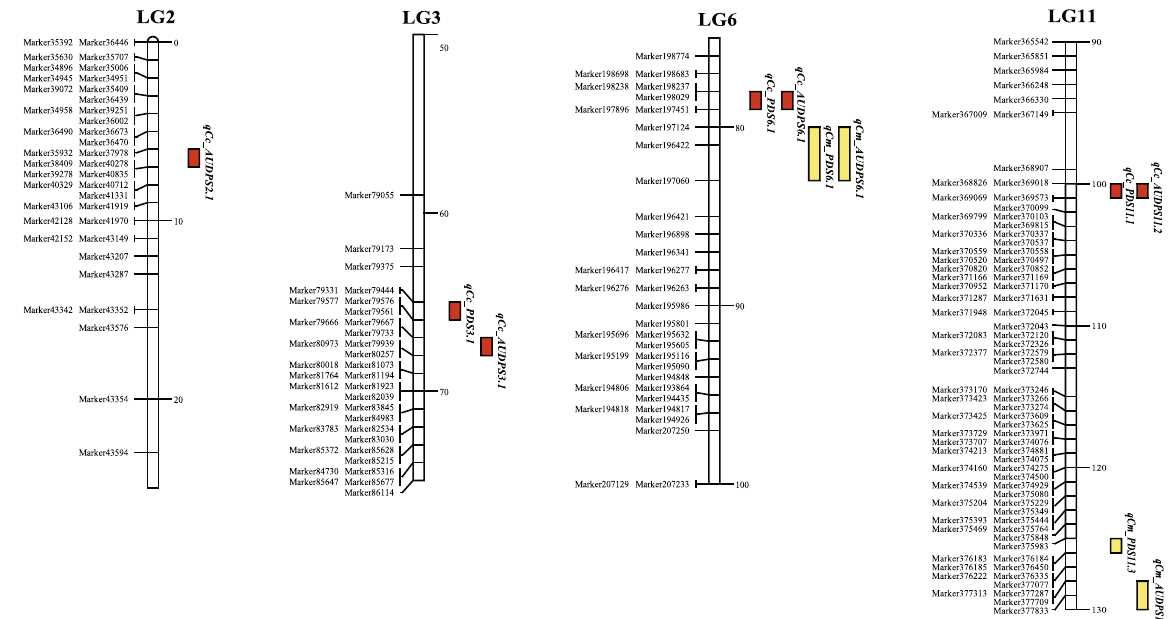
Figure 4. Linkage group locations of the QTLs identified for the percentage of damaged seeds and the AUDPS resulting from C . chinensis and C . maculatus infestations in the Vigna vexillata F 2 population of a cross between ‘TVNu 240’ and ‘TVNu1623’. Bars next to linkages indicate locations of the QTLs based on 1-LOD support. Only partial linkages at QTL sites are